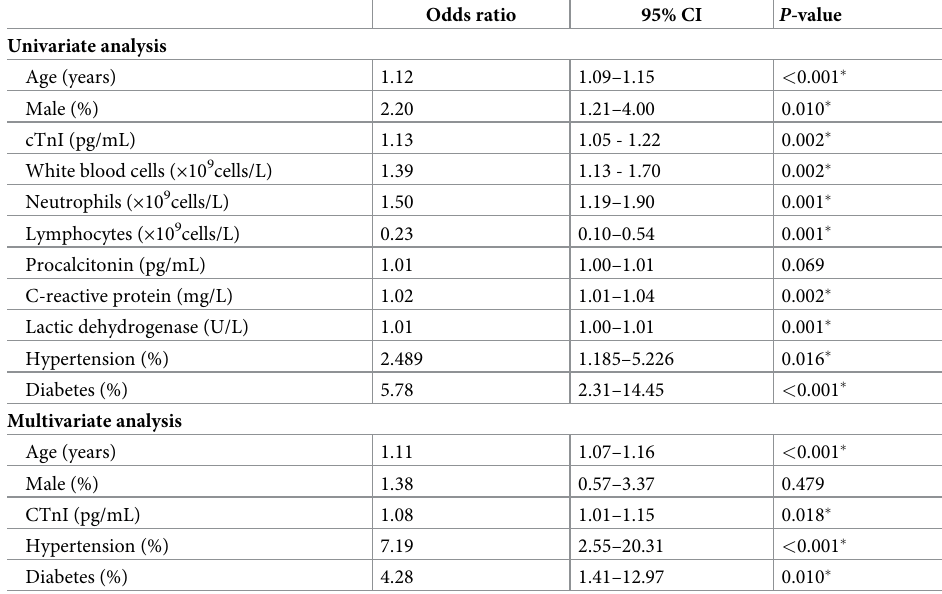
Table 8. Univariate and multivariate analysis for clinical severity of COVID-19.